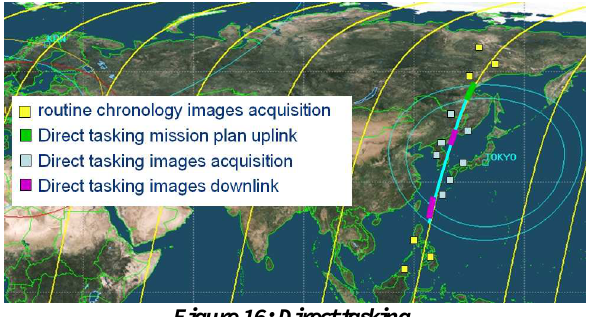
Figure 16: Direct